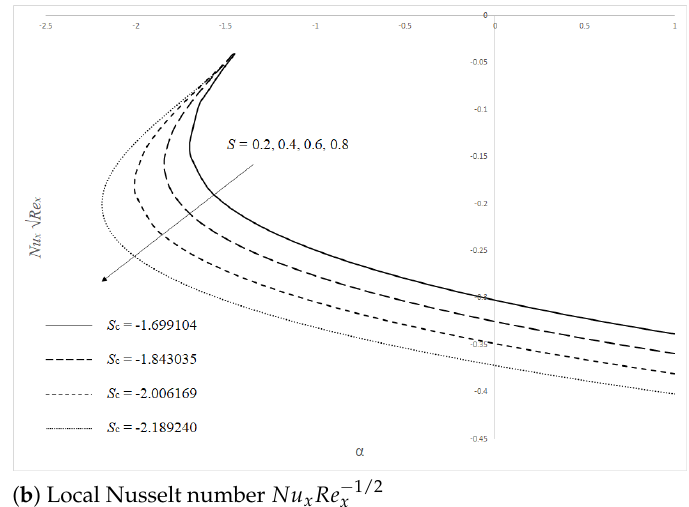
Figure 2. C fx Re 1/2 x and Nu x Re − 1/2 x for Al 2 O 3 –Cu/water with S and α .